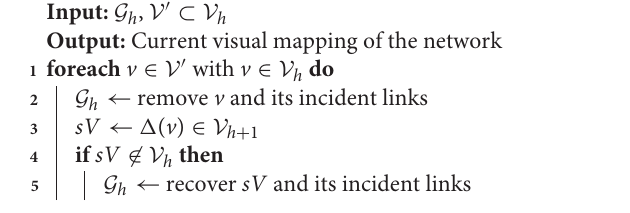
Algorithm 3: Collapse selected nodes one level